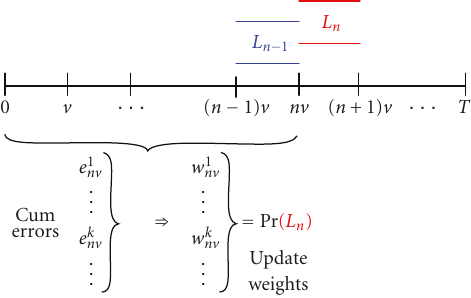
Figure 2: A diagram to illustrate the sequentially updated algo- rithm. At each t = nv , accumulated errors e k weights w k nv